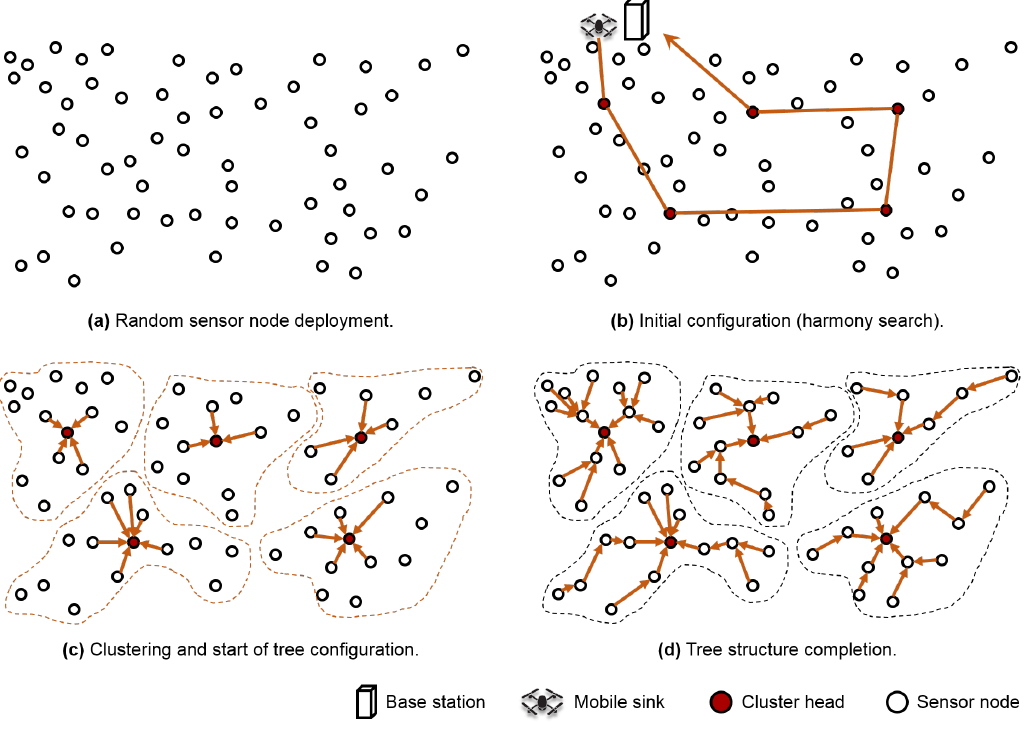
Figure 2. The initial clustering